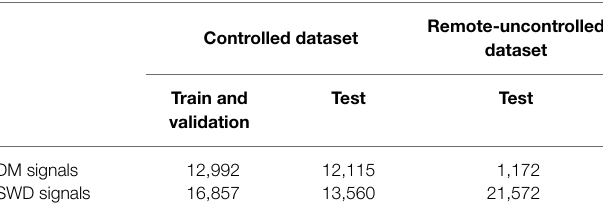
TABLE 1 | The number of signals for the two datasets used in this study (Controlled and Remote-Uncontrolled) and the data splits we applied.